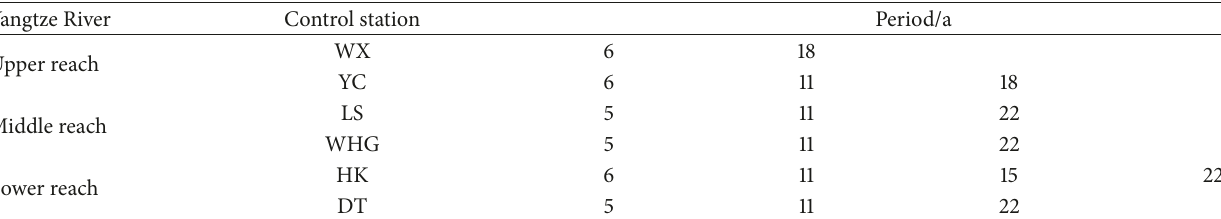
Table 6: The streamflow wavelet analysis